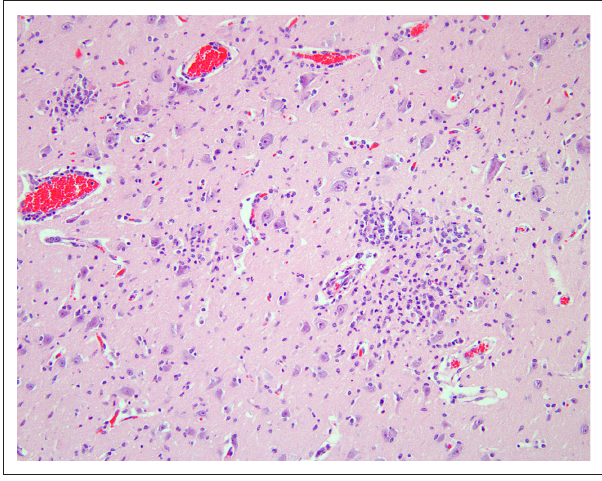
FIGURE 7: Olfactory cortex of lineage 2 West Nile virus infected Case 4 – multifocal glial nodules, diffuse gliosis and perivascular lymphoplasmacytic and histiocytic cuffing.